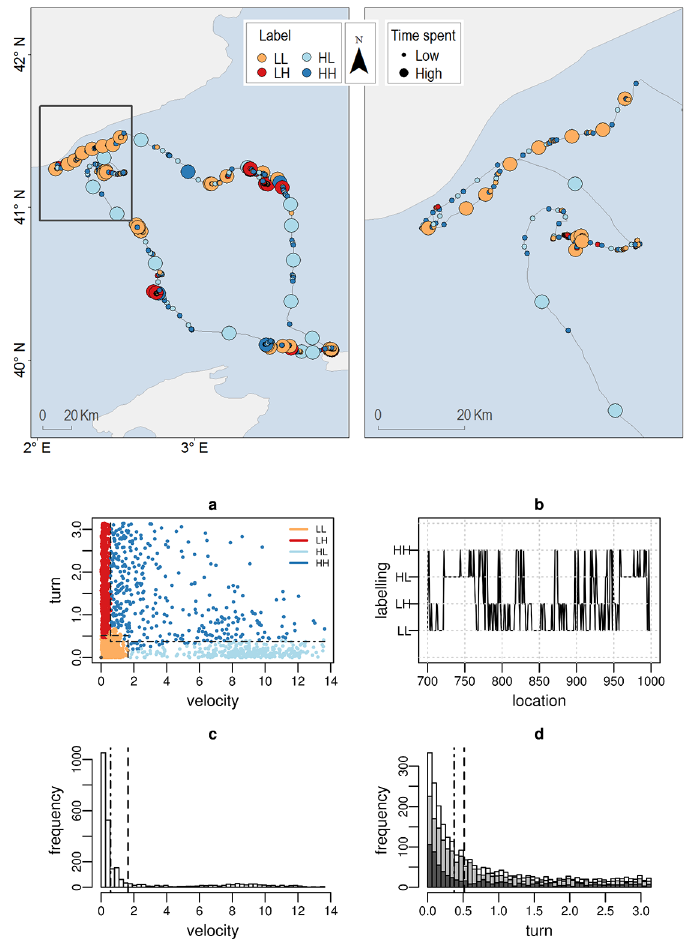
Fig 7. Cory ’ s shearwater ( Calonectris diomedea ) foraging trajectory. Upper panel: Burst-wise labelled foraging trajectory. Symbolization by label (LL:orange, LH:red, HL:cyan, HH:blue) and time spent (symbol size: 2 natural jenks). Scale bar is only approximate. Due to copyright restrictions the figure is for representative purposes only. Source: Made with Natural Earth; Free vector and raster map data @ naturalearthdata.com. Bottom panels: (a) velocity/turn scatter plot (clustering colour code: LL:orange, LH:red, HL:cyan, HH:blue), (b) temporal behavioural profile (from location 700 to 1000) (c) velocity ( m / s ) and (d) turning angle ( rad ) frequency distributions (white colour). The turn distribution for low/high values of velocity is shown separately in light/dark grey colours, respectively. The black lines in panels a, c and d depict the delimiters r . L , r L . (dashed lines) and r . H , r H . (dot-dashed